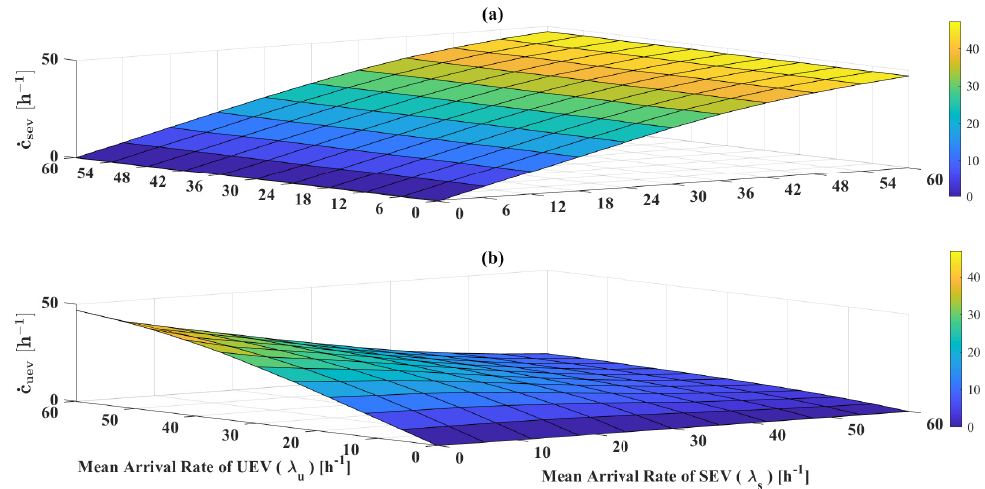
Figure 6. Mean charging completion rate of EVs with λ s and λ u .